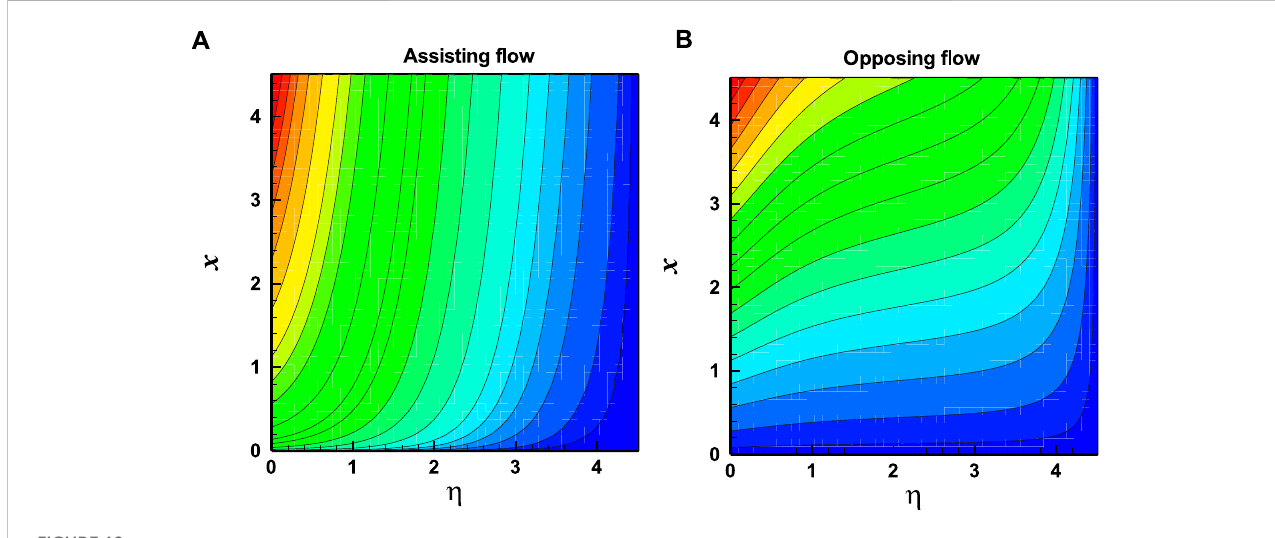
FIGURE 12 Variation of Isotherms for assisting and opposing fl ow with Nb (cid:1) 0 . 3 , Nt (cid:1) 0 . 5 , Le (cid:1) 1 , Pr (cid:1) 3 . 97 , β (cid:1) γ (cid:1) 0 . 3 , Nc (cid:1) 0 . 5 , Gr (cid:1) 0 . 5 , M (cid:1) 0 .